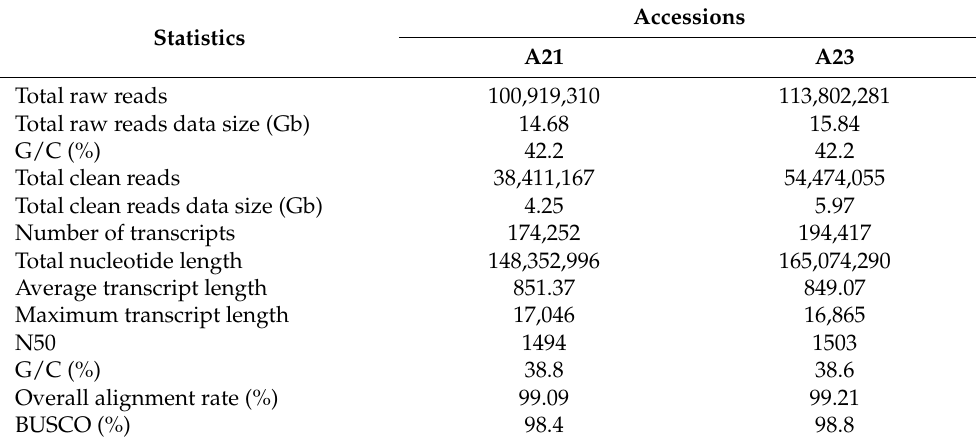
Table 1. Summary of raw and clean reads statistics before and after processing, de novo assemblies, and BUSCO completeness for tree tomato accessions A21 and A23.